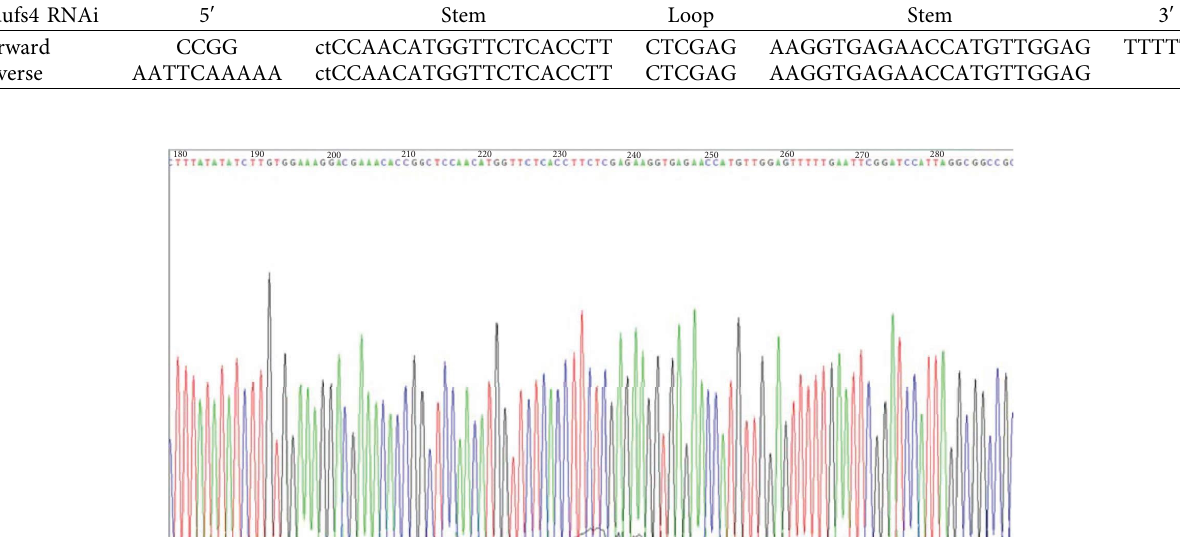
Table 2: Te Ndufs4 interfering sequence oligonucleotide strand.